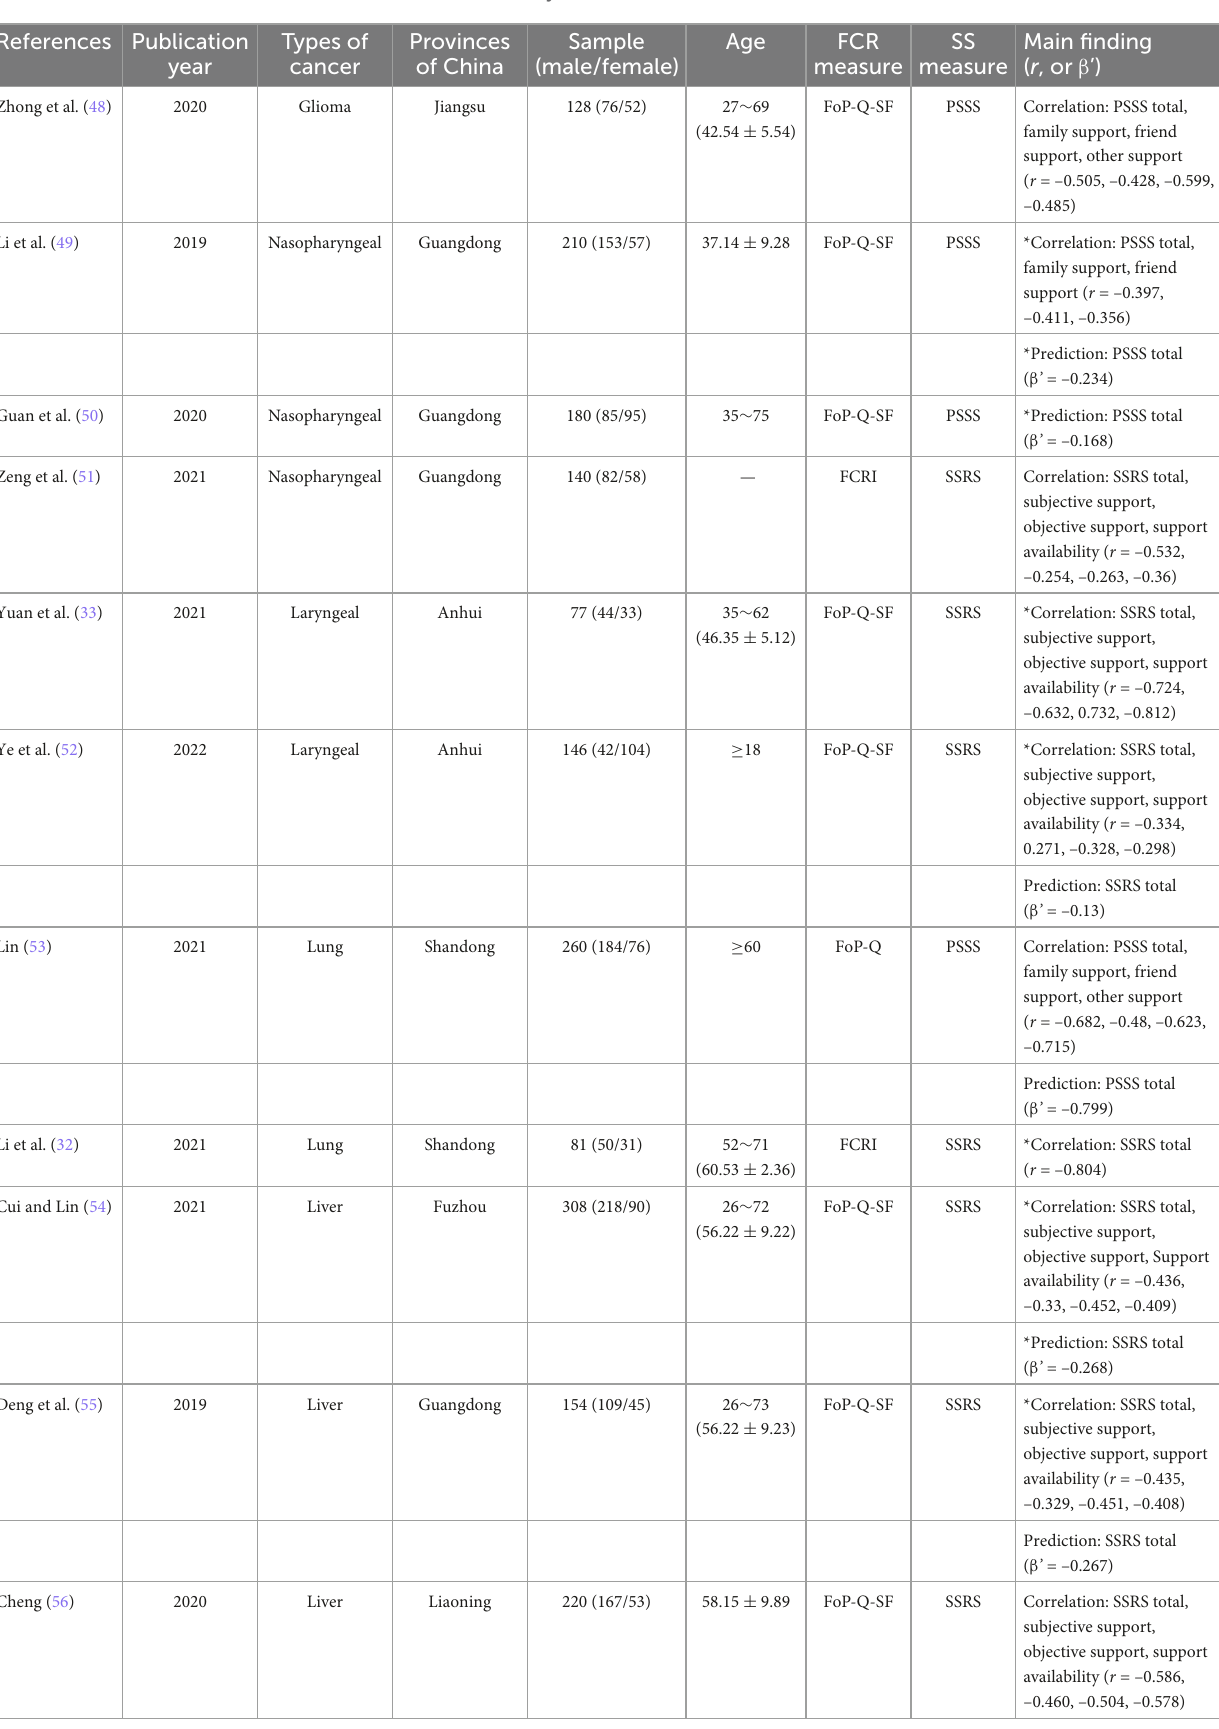
TABLE 2 The characteristics of 37 studies included in this